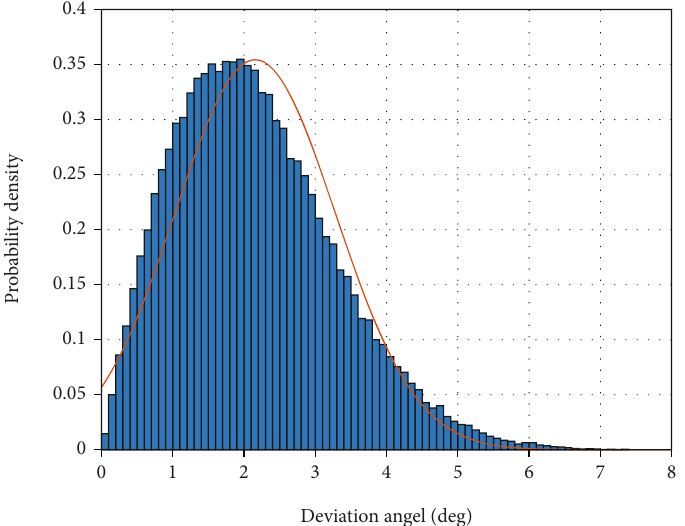
Figure 5: Probability density histogram of the angles that the available navigation stars deviate from the optimal navigation star. Table 1: The basic analysis results of the available navigation star deviation from the optimal navigation star. Event Maximum Minimum Mean Square 3 σ range Value (deg) 7.4221